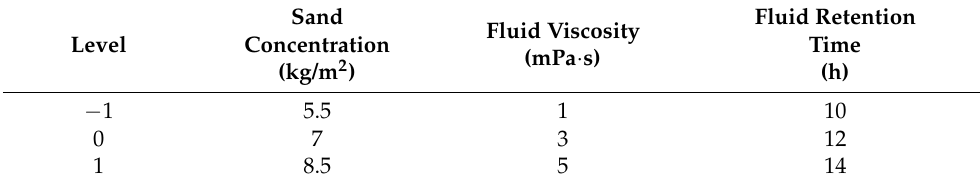
Table 1. Conductivity Damage Response Surface Factor Level.